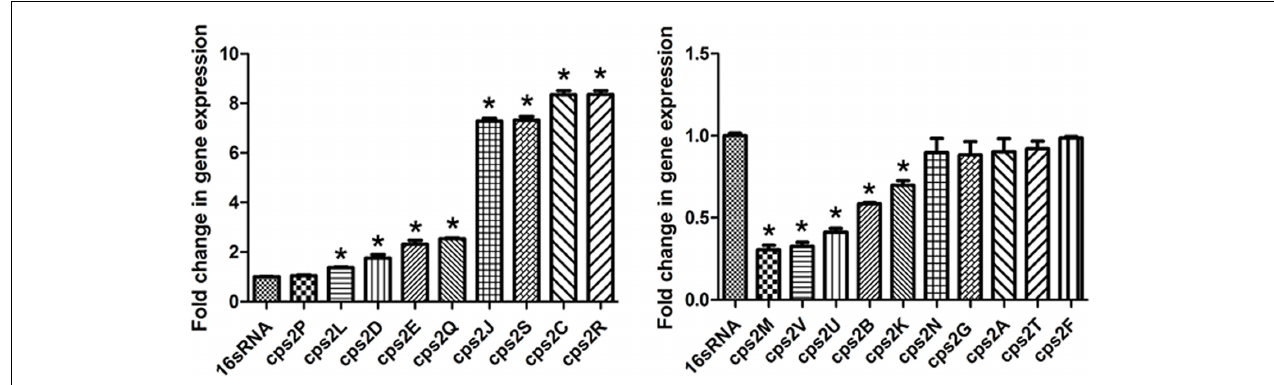
FIGURE 6 | Effect of rutin on mRNA expression of cps genes in S. suis . The data are expressed as means ± standard deviations. The expression was normalized to 16S rRNA. Controls refer to the absence of rutin. Asterisk indicates statistically significant difference of treatment versus untreated culture ( ∗ p < 0.05).